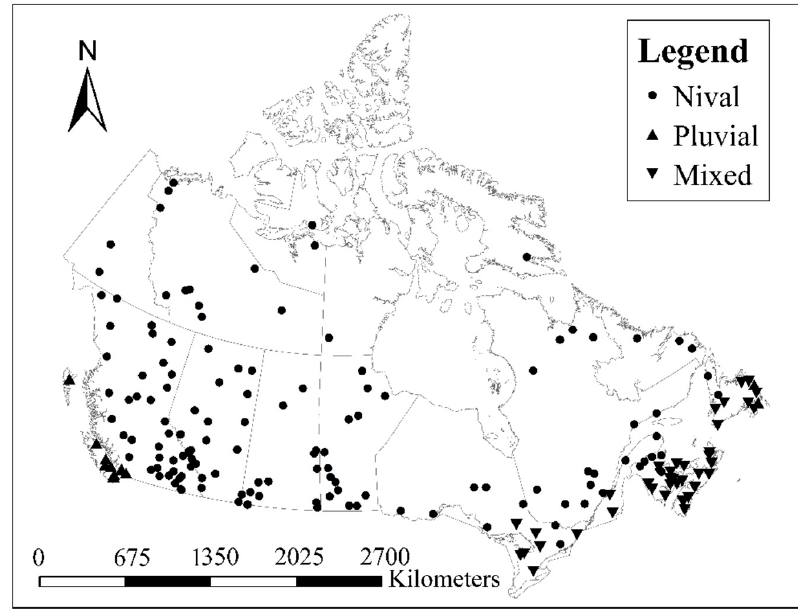
Figure 1. Geographical location of 186 study sites identifying primary cause of flood response.